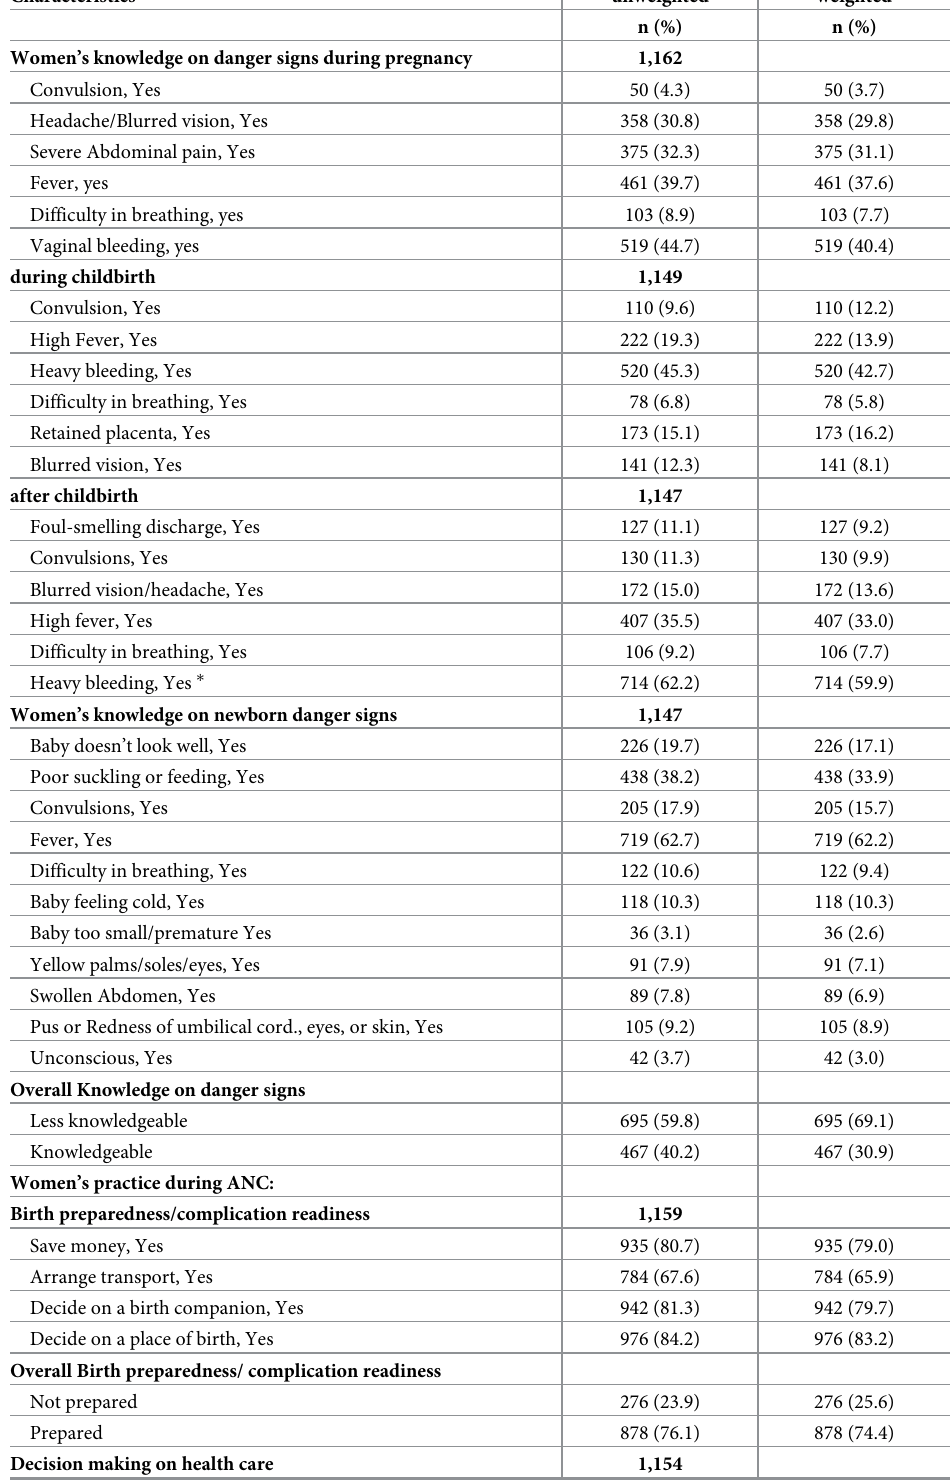
Table 2. Receiving of ANC components in Mara and Kagera regions,